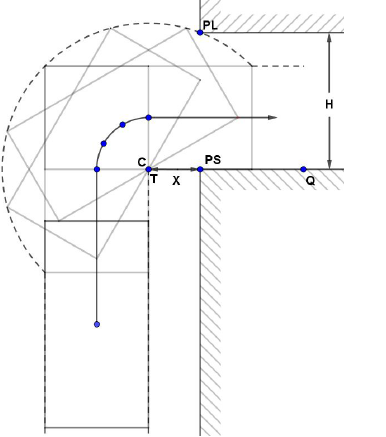
Figure 9. The trajectory of RRB when X ≥